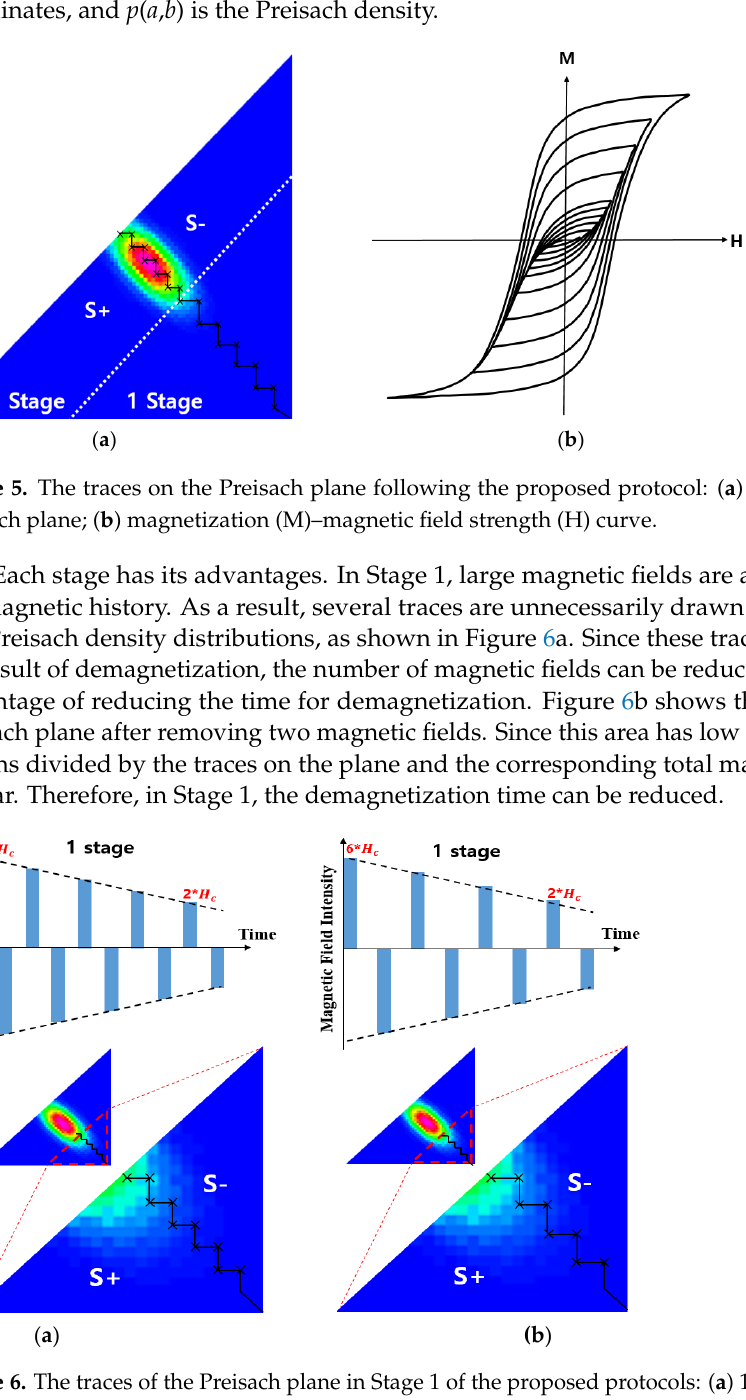
( a ) ( b ) Figure 7. Schematic view of Stage 2 of the proposed protocols: ( a ) Stage 2 of the proposed proto- col; ( b ) the traces on the Preisach plane. Since the proposed protocol has both excellent performances of Deperm-ME and convenient control of Anhysteretic Deperm, it can be used in the real environment. In addition, it can reduce the demagnetization time. 3. Simulation and Experiment Setup Simulations were performed through a program that combines the Preisach model and Finite Element Method (FEM) to verify the proposed protocol. In addition, experi- ments were conducted to verify the simulation results. Since the magnitude of the earth’s magnetic field is dependent on the operation areas and the effect of the earth’s magnetic field is compensated by degaussing after demagnetization, for the basic re- search of the deperming protocol, the effect of the earth’s magnetic fi eld was removed and the experiment was carried out in a Magnetic Treatment Facility. Figure 8 shows a specimen and the deperming coil used in the simulations and ex- periments. The length, outer, and inner diameter of the specimen made of the Steel Plate Cold Commercial (SPCC) magnetic material were 298, 44, and 42 mm, respectively. The demagnetizing coil was 557 mm long, 60.4 mm in diameter, and folded in 606 turns. The B-H curve of the SPCC and the Preisach density distribution are shown in Figure 9.